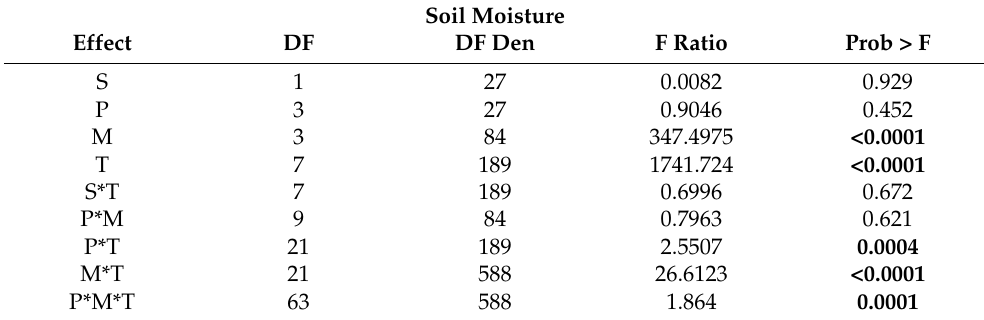
Table 8. Statistical results of a glass house study evaluating the effect of species (S), SAP placement depth (P), moisture measurement depth (M), time (T), and their interactions on soil moisture. Bolded numbers indicate p < 0.05.